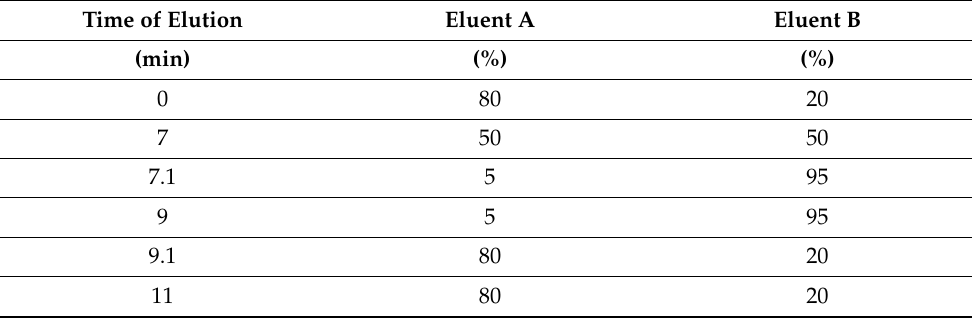
Table 1. Time and percentages of used eluents during HPLC-MS analysis. Time of